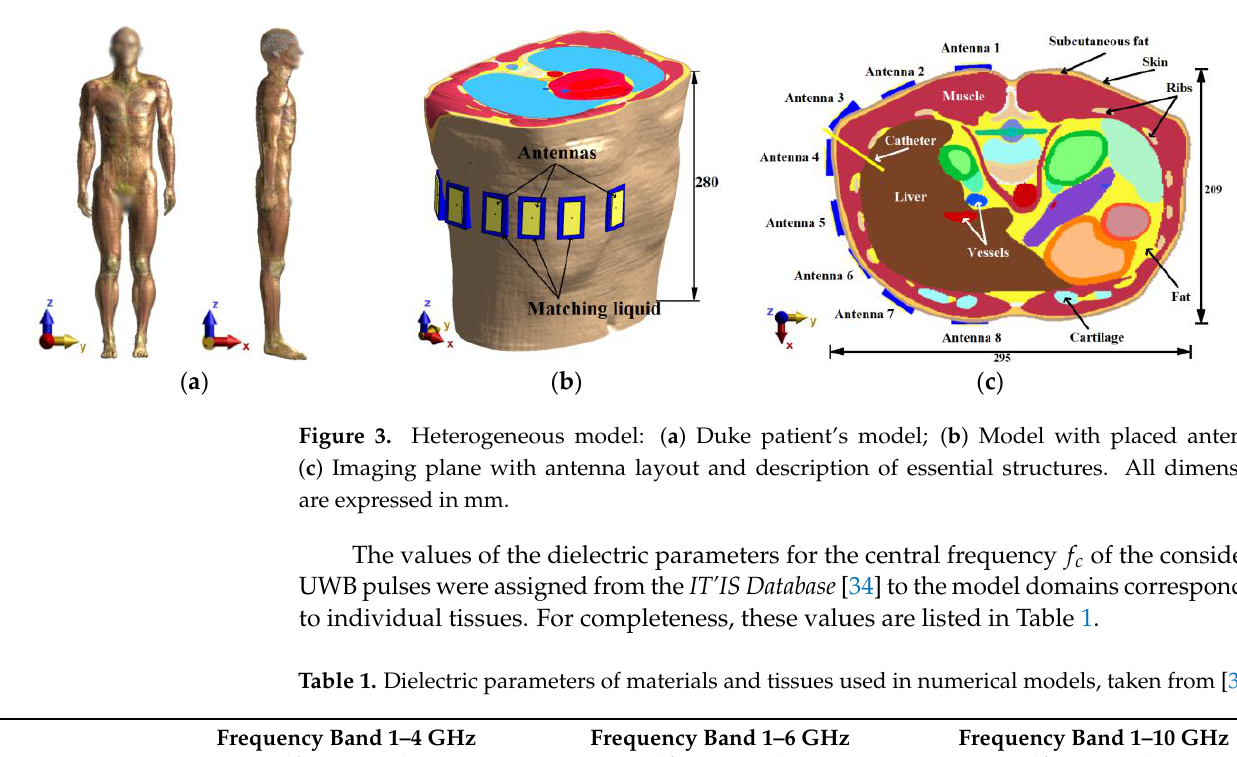
Table 1. Dielectric parameters of materials and tissues used in numerical models, taken from [34].